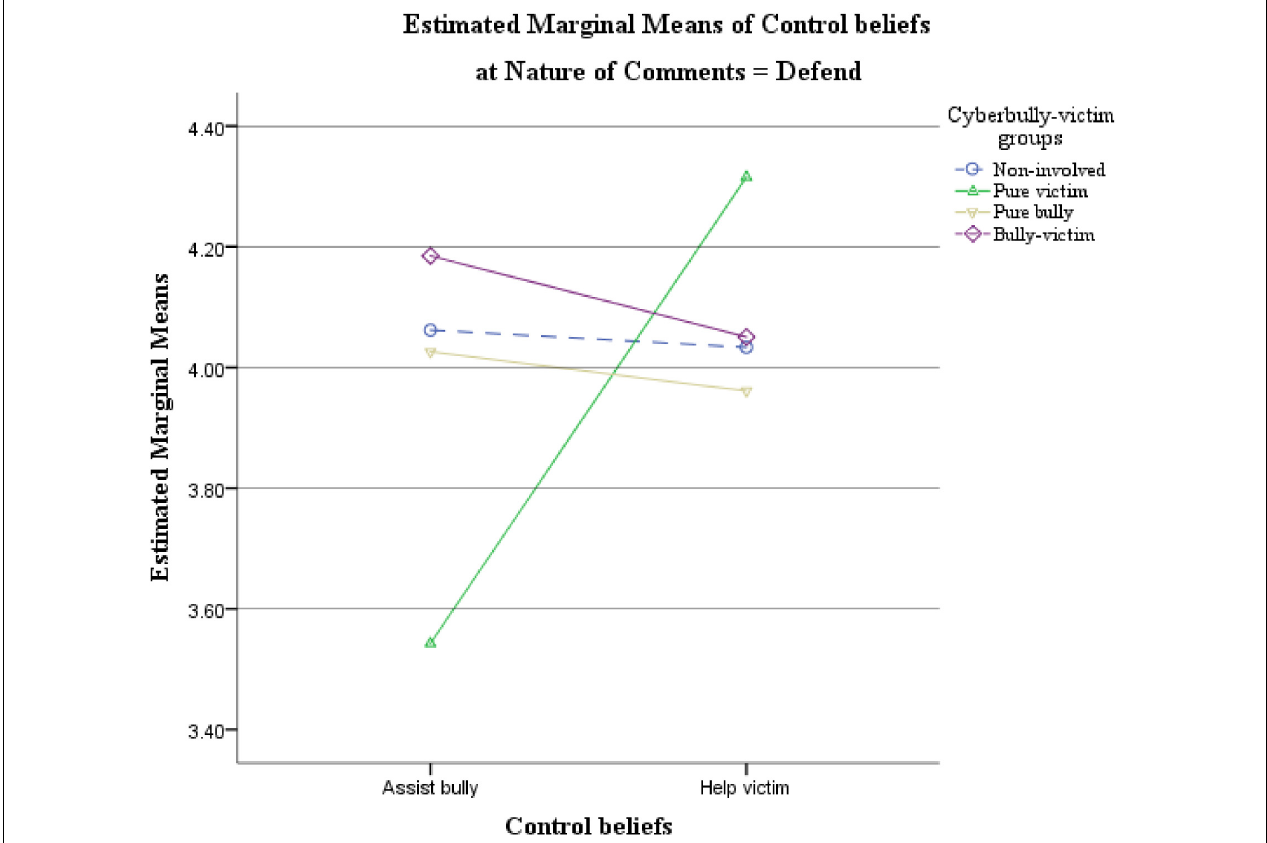
FIGURE 2 | Estimated marginal means of the 2-way interaction between cyberbully-victim group and type of control beliefs about bystander behaviors in the defend